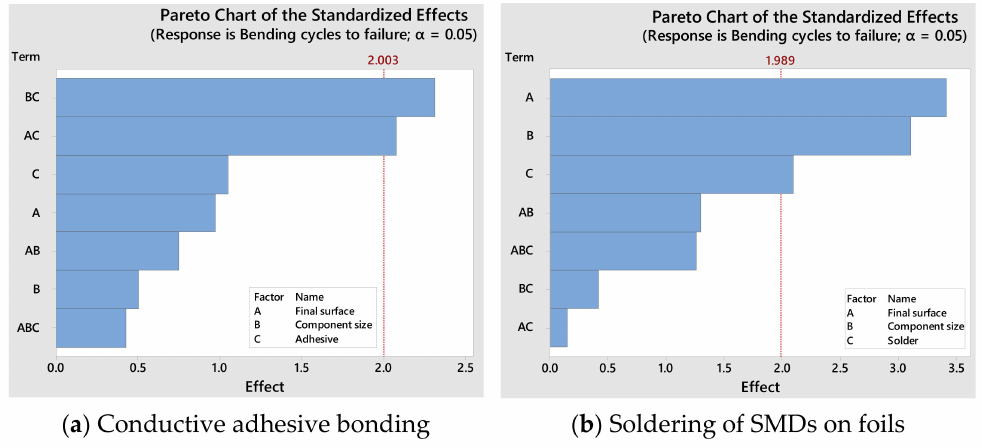
Figure 11. Pareto charts of the effects of the parameters influencing the bending cycles to